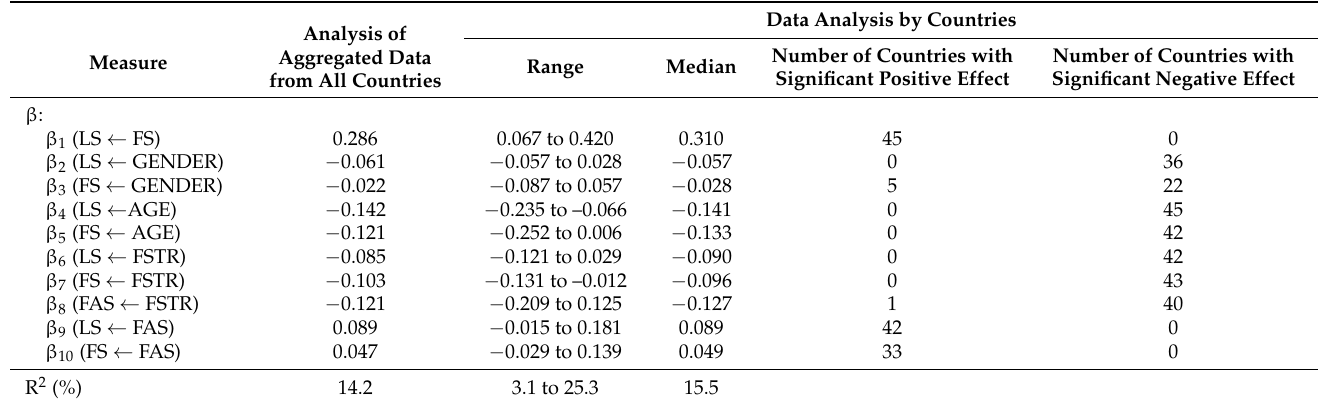
Table 6. Standardised regression weights ( β ) and squared multiple correlation (R 2 ) in path analysis of the total sample of all 45 HBSC